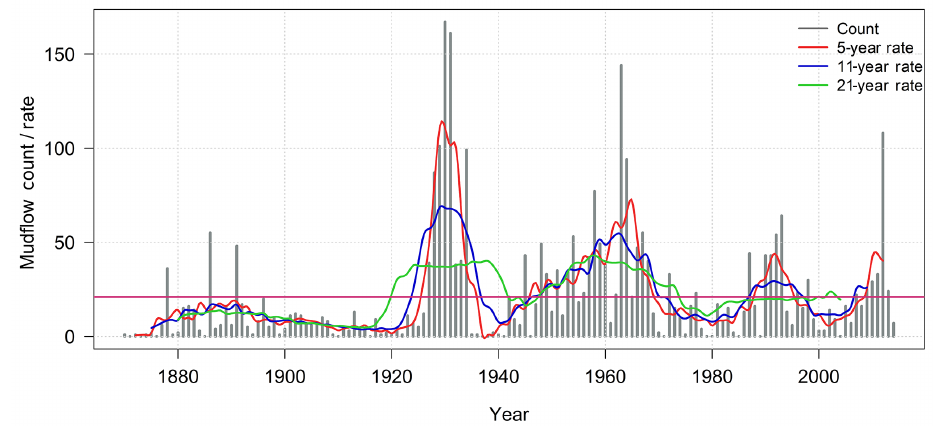
Figure 6. Variability in mudflow events in Uzbekistan (1870–2014). Vertical bars present the mudflow observations for each year. The mean annual mudflow count (21) is indicated in a solid continuous horizontal line (pink). Curves (red, blue, green) have been fitted to the distribution for illustrative purposes and denote the 5-, 11- and 21-year rates of mudflow